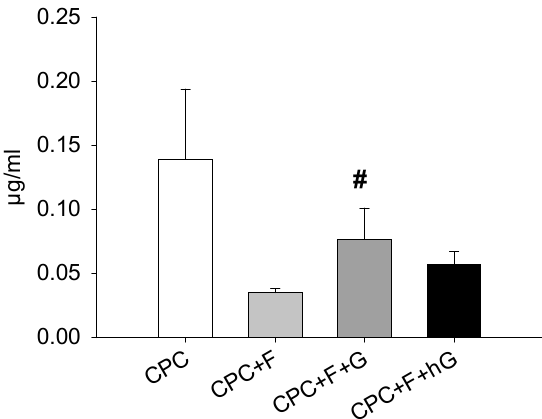
Figure 9. Effects of GDF5 extracts on the intracellular concentration of collagen 1 protein in hASCs. hASCs were seeded in 12-well plates and exposed for 3 days to the diluted extracts of CPC discs without fibers (CPC) and with 10% ( w / w ) fiber content (CPC+F), the latter either without GDF5 or doped with low dose (10 µg/mL; CPC+F+G) or high dose GDF5 (200 µg/mL; CPC+F+hG). Thereafter, collagen 1 concentrations in cell lysates were quantified using a commercial ELISA kit. The data are expressed as means ± SEM ( n = 8); # p ≤ 0.05 Mann–Whitney U test vs. CPC+F.